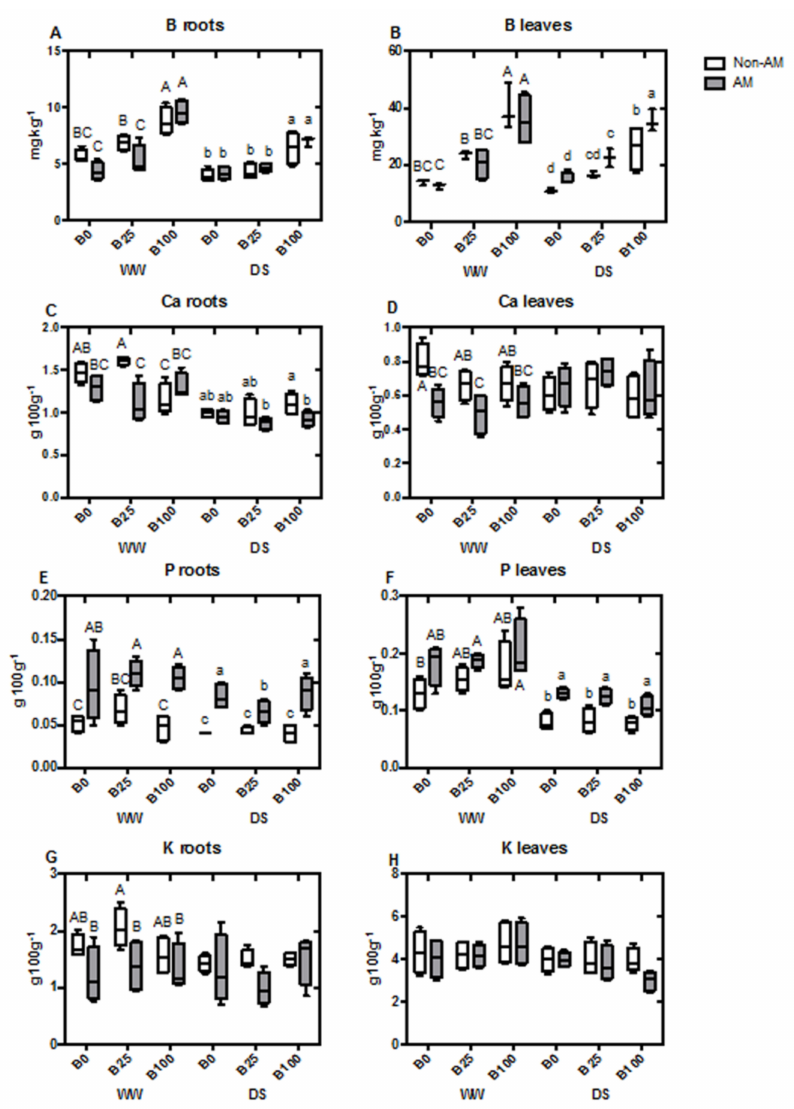
Figure 1. Boxplots representing concentrations of B in roots ( A ) and in leaves ( B ), Ca in roots ( C ) and in leaves ( D ), P in roots ( E ) and in leaves ( F ) and K in roots ( G ) and in leaves ( H ). Boxes represent the interquartile range, with the line representing the median, whiskers represent maxima and minima within 1.5 times the interquartile range. Di ff erent letters indicate significant di ff erences among treatments ( p < 0.05) based on Duncan’s